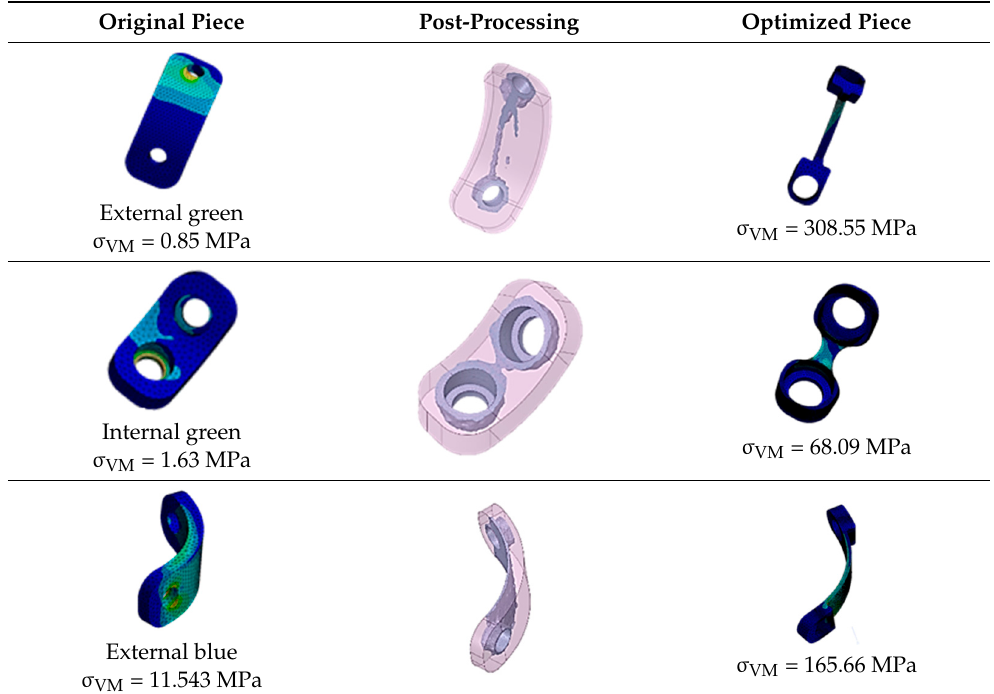
Table 8. Results of the spherical manipulator mechanism.